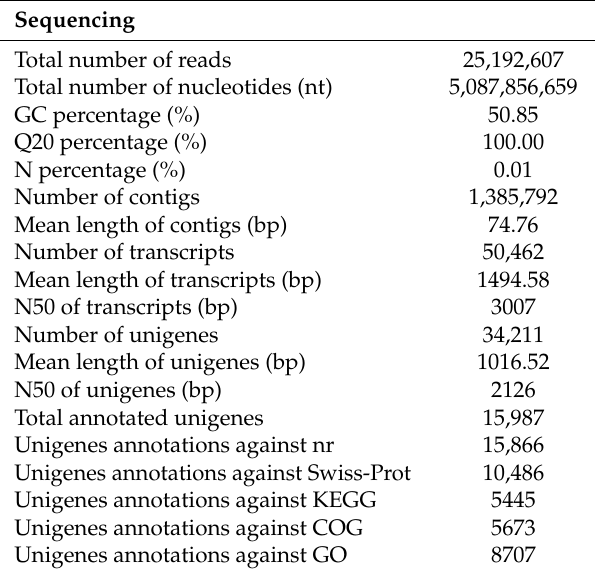
Table 2. Primary description of the N. barkeri